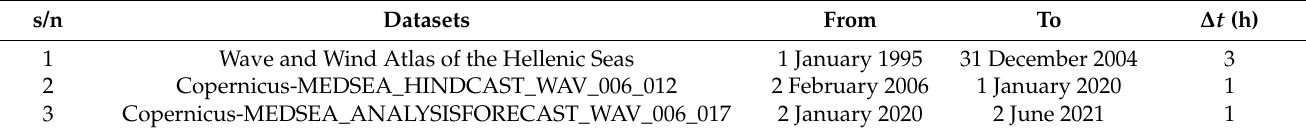
Table 1. The available datasets used to extract wave scenarios. s/n Datasets From To ∆ t